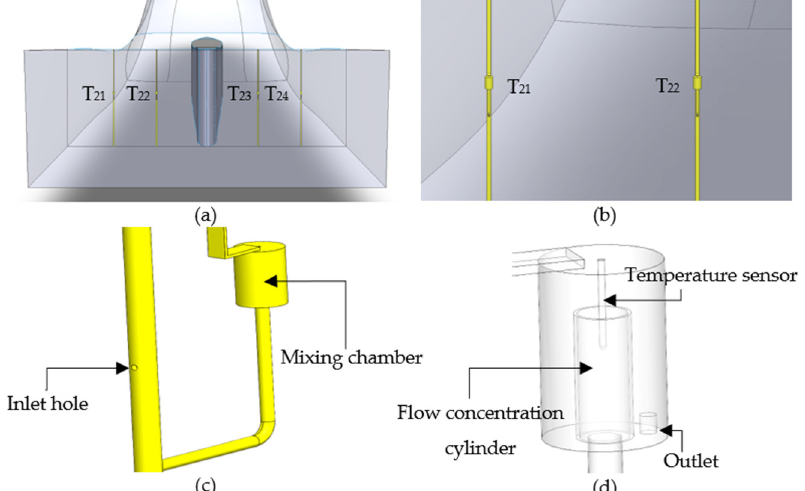
Figure 5. Manifold vessels coupling, outlet section: ( a ) manifolds T 21 , T 22 , T 23 and T 24 , ( b ) view outlet section left, ( c ) isometric view of manifold vessel, ( d ) mixing chamber (inside).